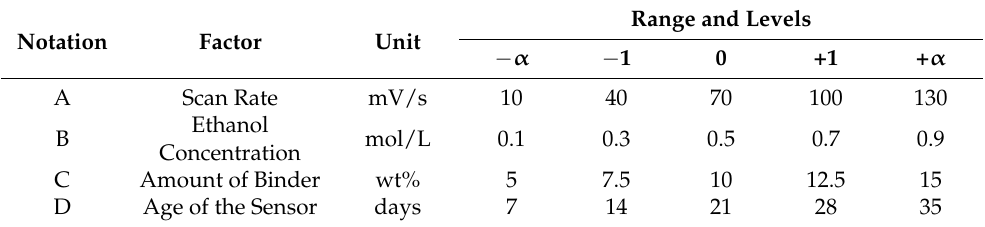
Table 1. Experimental factors and levels in the central composite design.